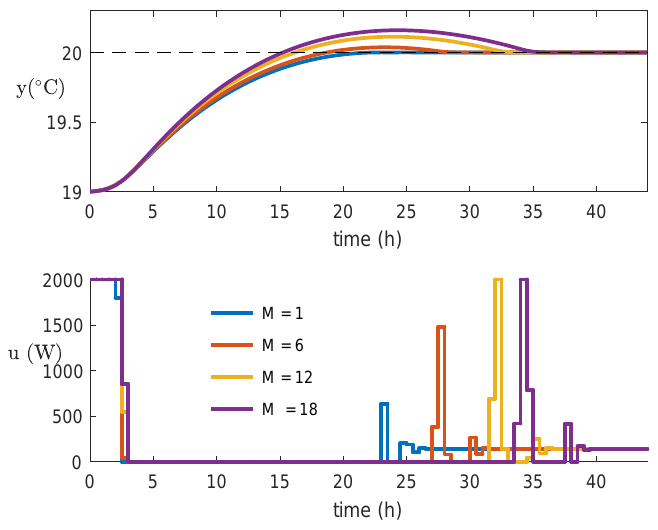
Figure 9. Room temperature and heat input profiles of EMPC with modified target zone Z (cid:48) Algorithm 1 with α = 2000 and M =